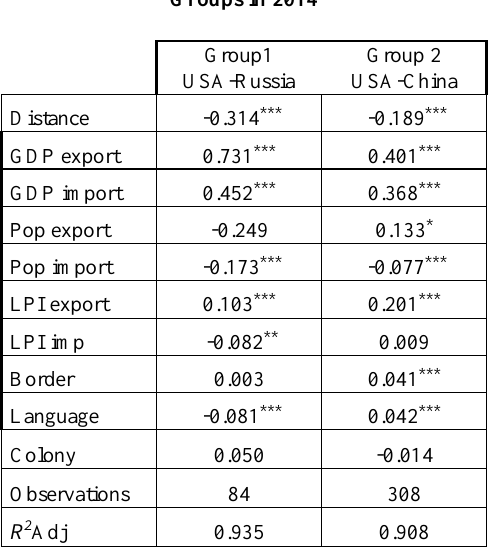
Table 6: Estimated Coefficients for Destination Groups in